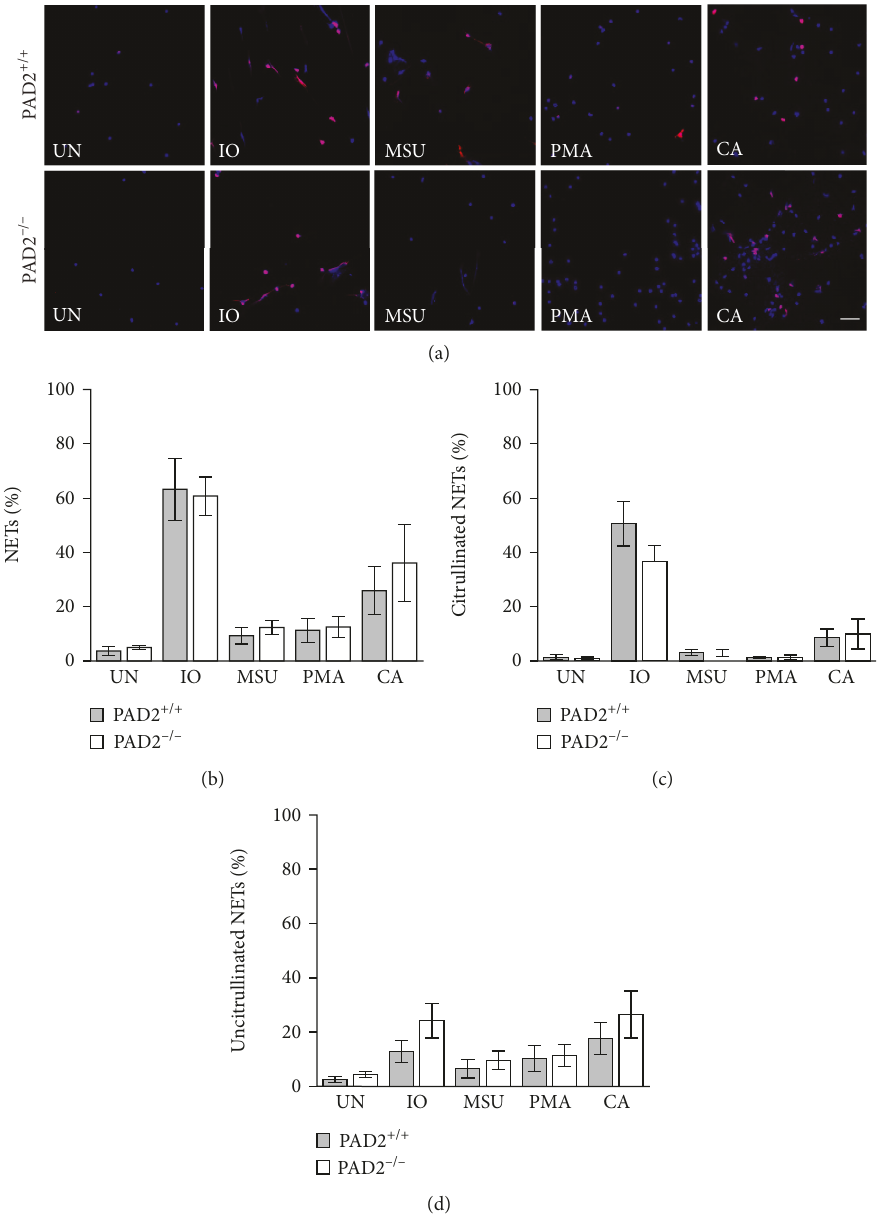
Figure 4: PAD2 is not required for the formation of NETs in murine neutrophils. Bone marrow neutrophils from PAD2 +/+ and PAD2 -/- mice were left untreated (UN) or were treated with ionomycin (IO), MSU, PMA, and C. albicans (CA), fi xed, and stained with DAPI (blue) and anti-citrulline antibody (pink). (a) Representative images at 400x, scalebar = 50 μ M . The number of neutrophils and NETs were quanti fi ed. Graphs depict the average and SEM for percent of neutrophils that formed total NETs (b), citrullinated NETs (c), and uncitrullinated NETs (d) for each condition with percent NETs for each stimulant compared between PAD2 +/+ and PAD2 -/- mice. For all panels: n = 4 ; no comparisons were signi fi